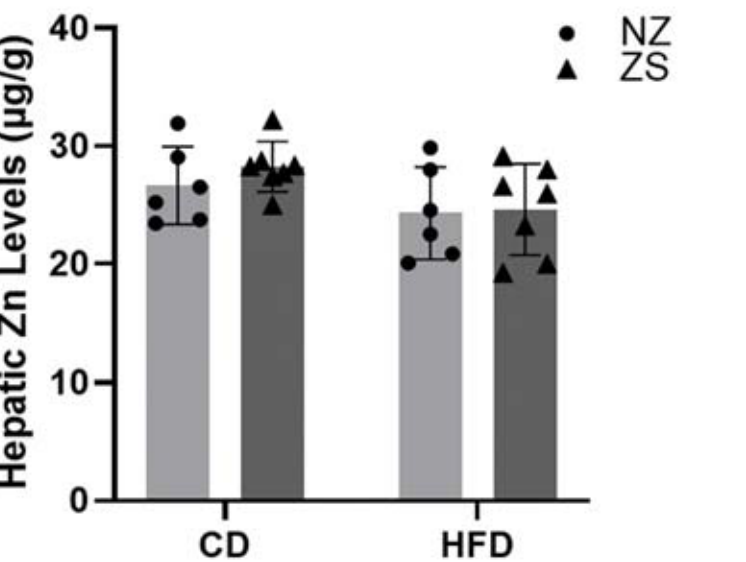
Figure 3. Hepatic zinc levels. Hepatic zinc content was measured by ICP-MS. Data are reported as mean ± SD (n = 14) significance set to 0.05. NZ = normal zinc, ZS = zinc supplement.